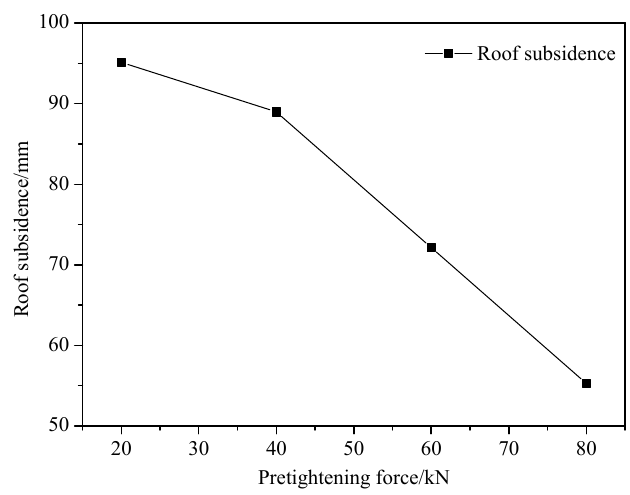
Figure 16. Variation of the roof subsidence for the roadway with different tightening forces.